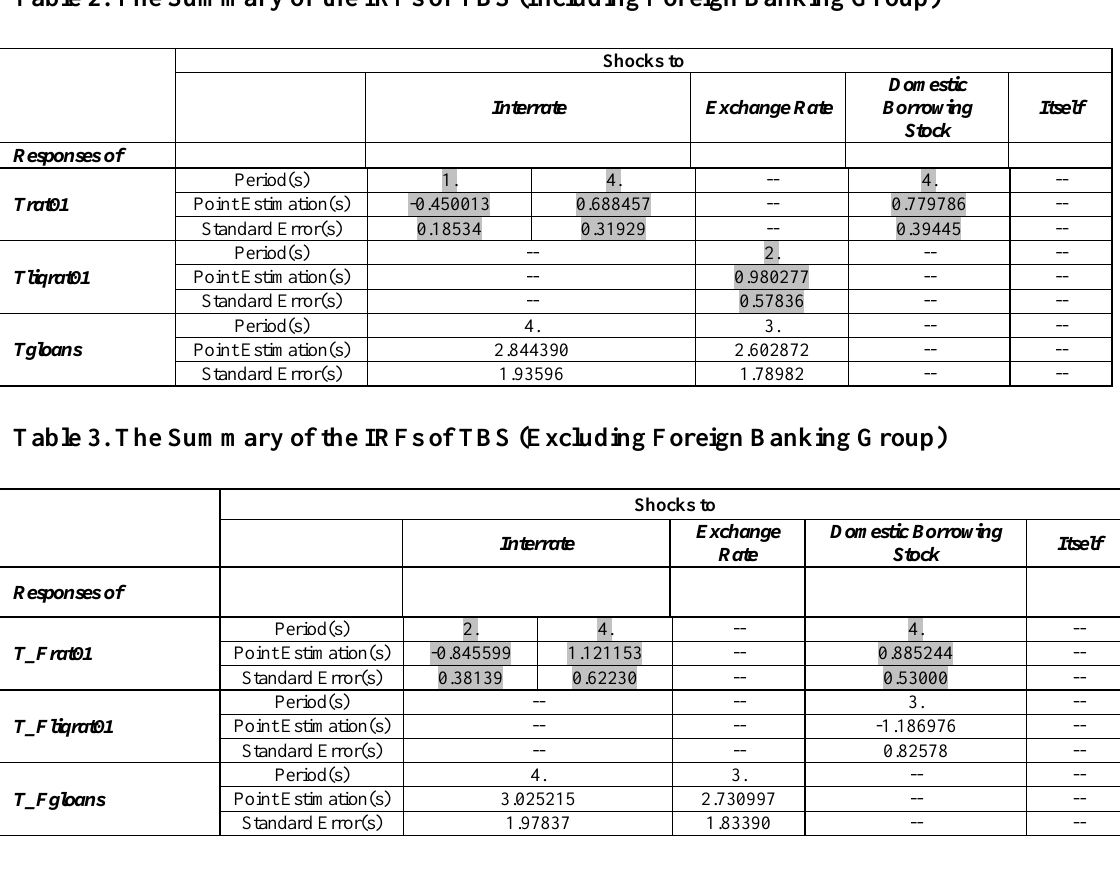
Table 2. The Summary of the IRFs of TBS (Including Foreign Banking Group)